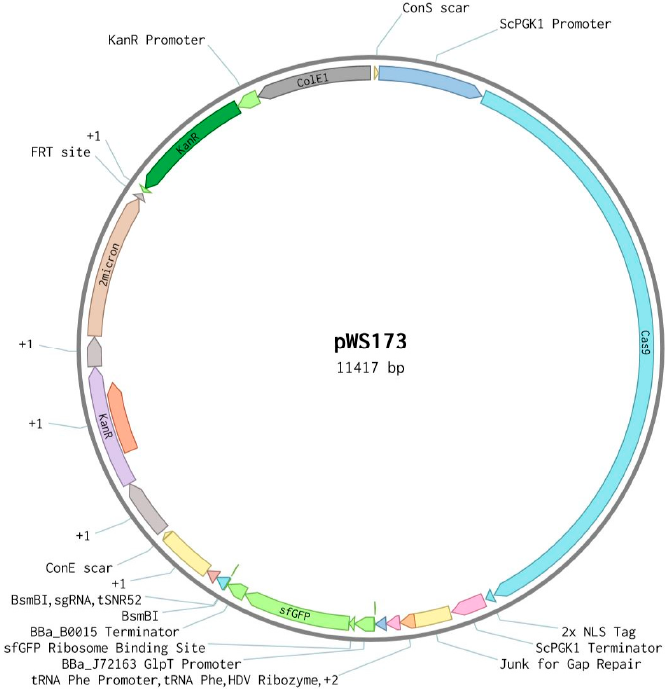
Figure 1. Representation of pWS173 plasmid (Benchling).